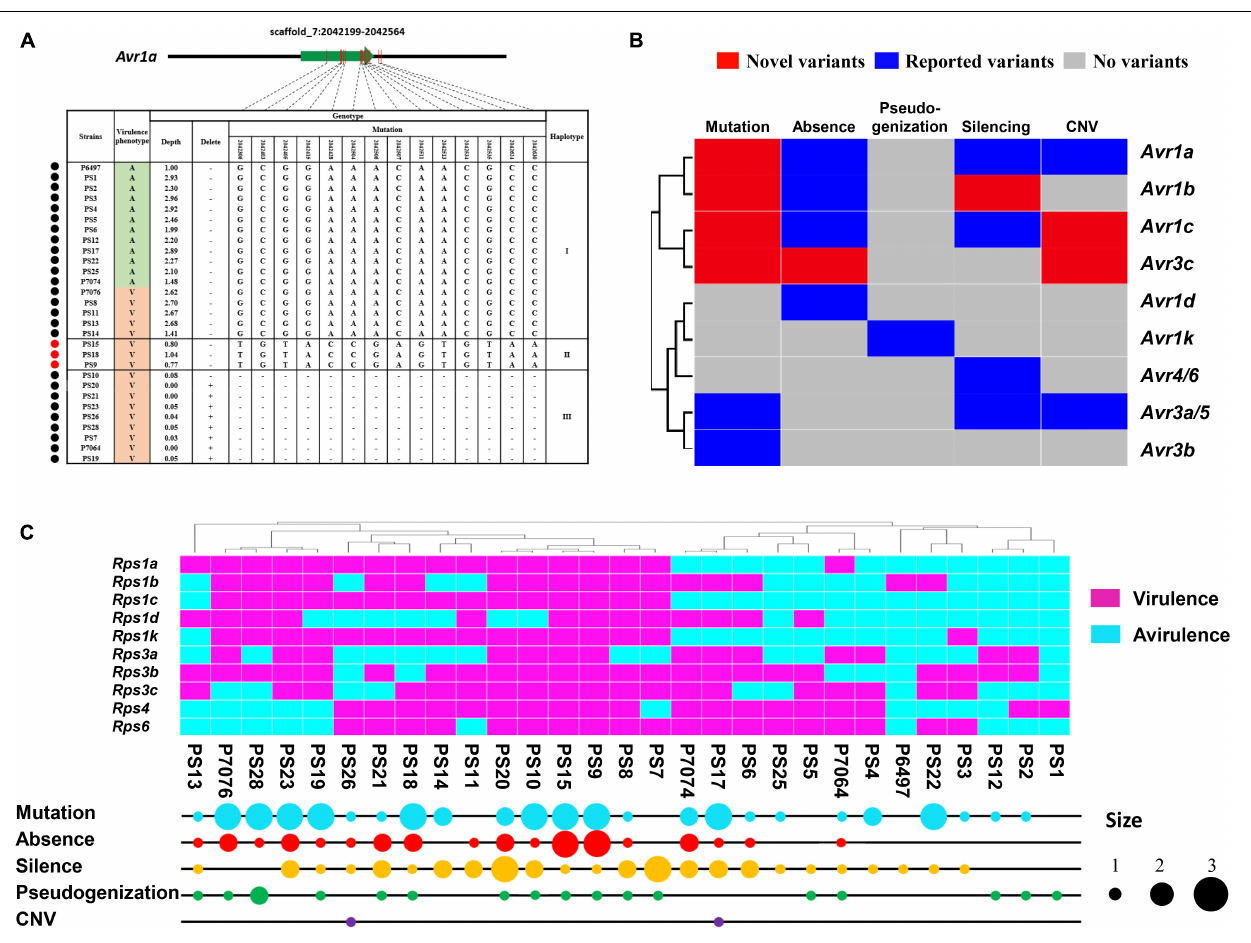
FIGURE 6 | Avr genes exhibit abundant sequence variation among 29 P. sojae isolates. (A) Structural and nucleotide diversity at the Avr1a locus among 29 P. sojae isolates. The green arrow indicates gene-coding region. Red vertical lines indicate variant regions of the gene. Variant positions and types are connected by dotted lines. Schematic graphs of the variant positions in all isolates are grouped by haplotypes. Black circles indicate previously reported haplotypes and corresponding phenotypes. Red circles indicate novel haplotypes and corresponding phenotypes. Disease outcomes on soybean plants harboring Rps1a are recorded as avirulent (A) or virulent (V). Variation positions are from P. sojae reference genome V3.0. (B) Summary of different variant types of the 9 Avr genes. X axis indicates variant types of corresponding Avr genes. “Novel variants” indicates new variant types identified in this study. “Reported variants” indicates variant types previously described. “No variants” indicates no variant being found. Y axis denotes cluster analysis generated by the Heml software using the variant types of Avr genes. (C) Summary of Avr variant types and virulence formulas across 29 P. sojae isolates. Bubble sizes are proportional to the numbers of corresponding variant types. Cluster analysis was generated by Heml using the virulence formulas of P. sojae